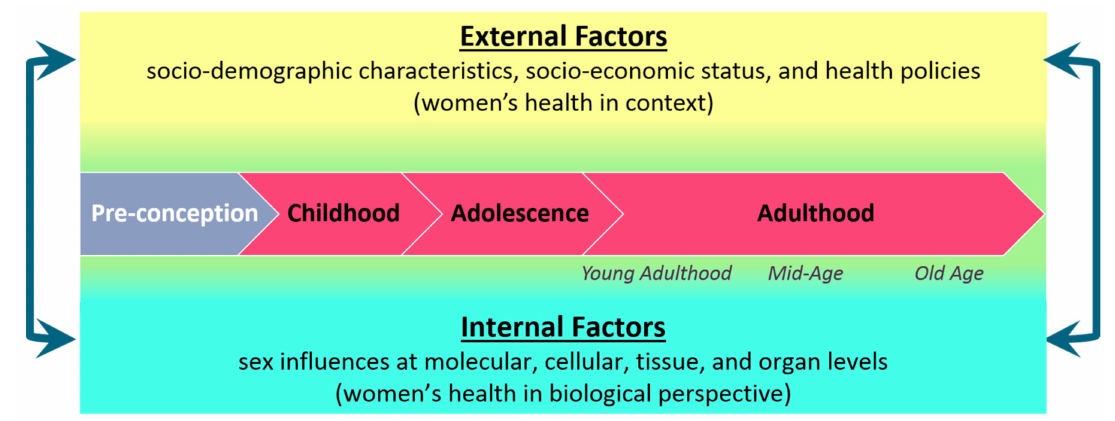
Figure 4. Multidimensional Model of Women’s Health across the Life Course. Internal and external factors, shown here continuously along the top and bottom, both 1. affect the individual (symbolized via flow through the middle) and 2. interact with each other (symbolized via the dual side arrows) across the life course. (This figure has not been referred to within the text of the manuscript, please